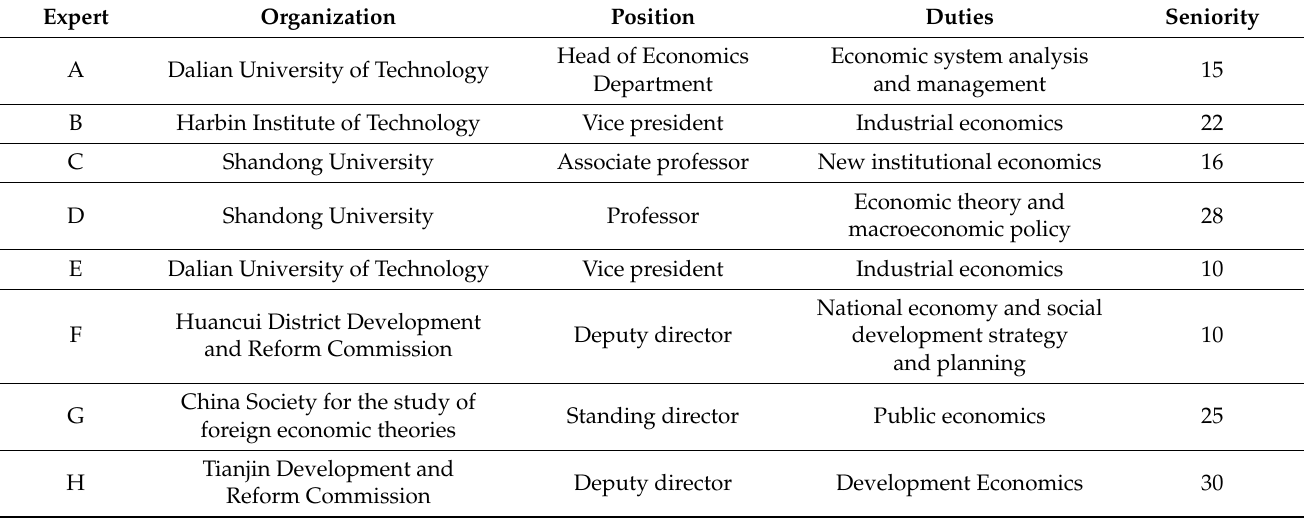
Table 4. Professional backgrounds of the selected eight experts for the Delphi survey.